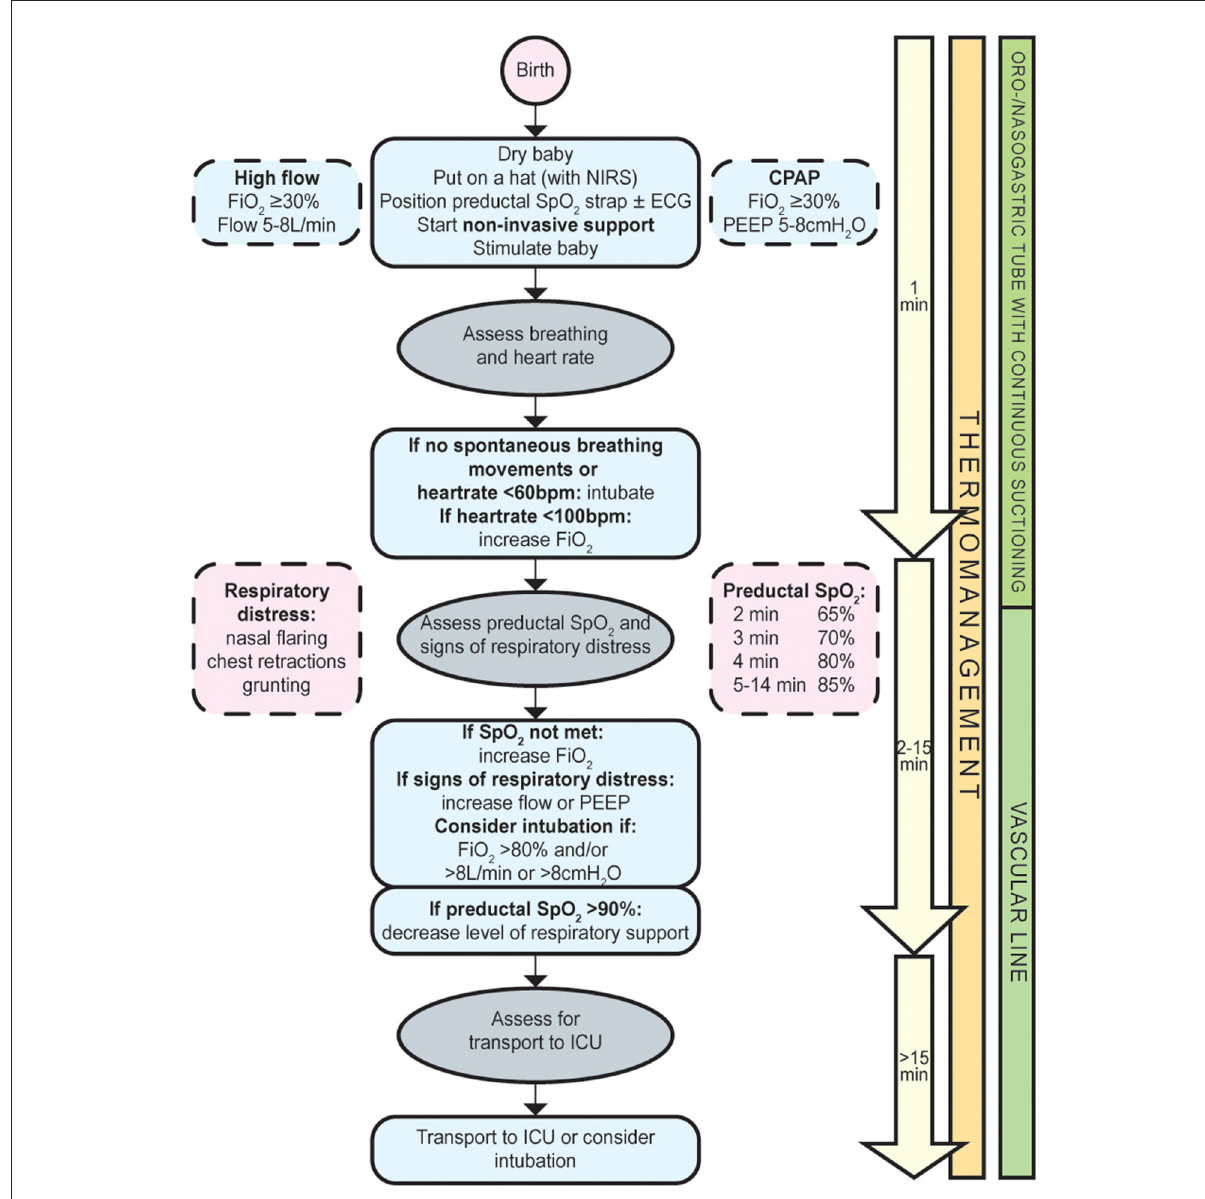
FIGURE1 Flowchart spontaneous breathing approach for infants with a congenital diaphragmatic